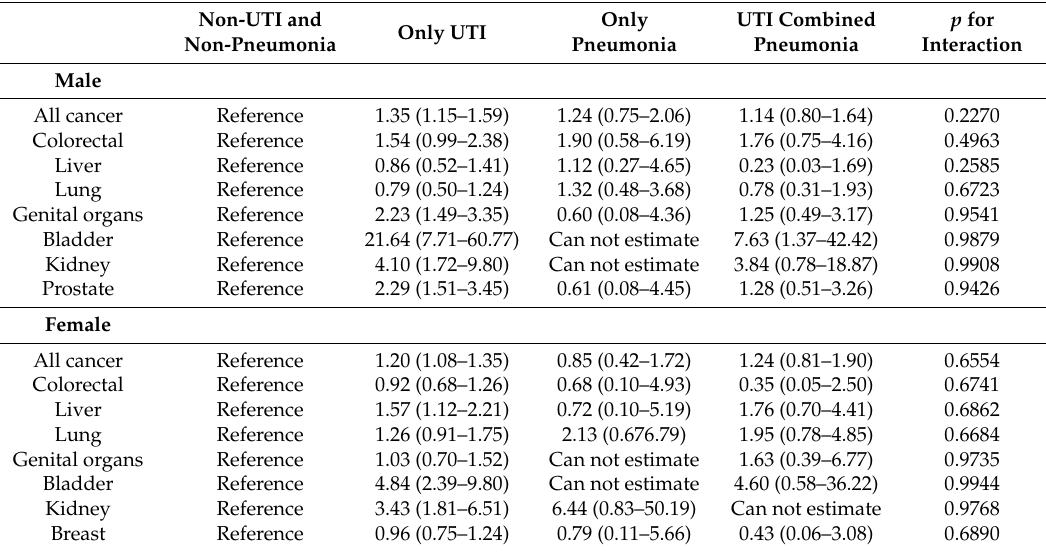
Table 5. Adjusted hazard risk † of cancer in patients with UTI or